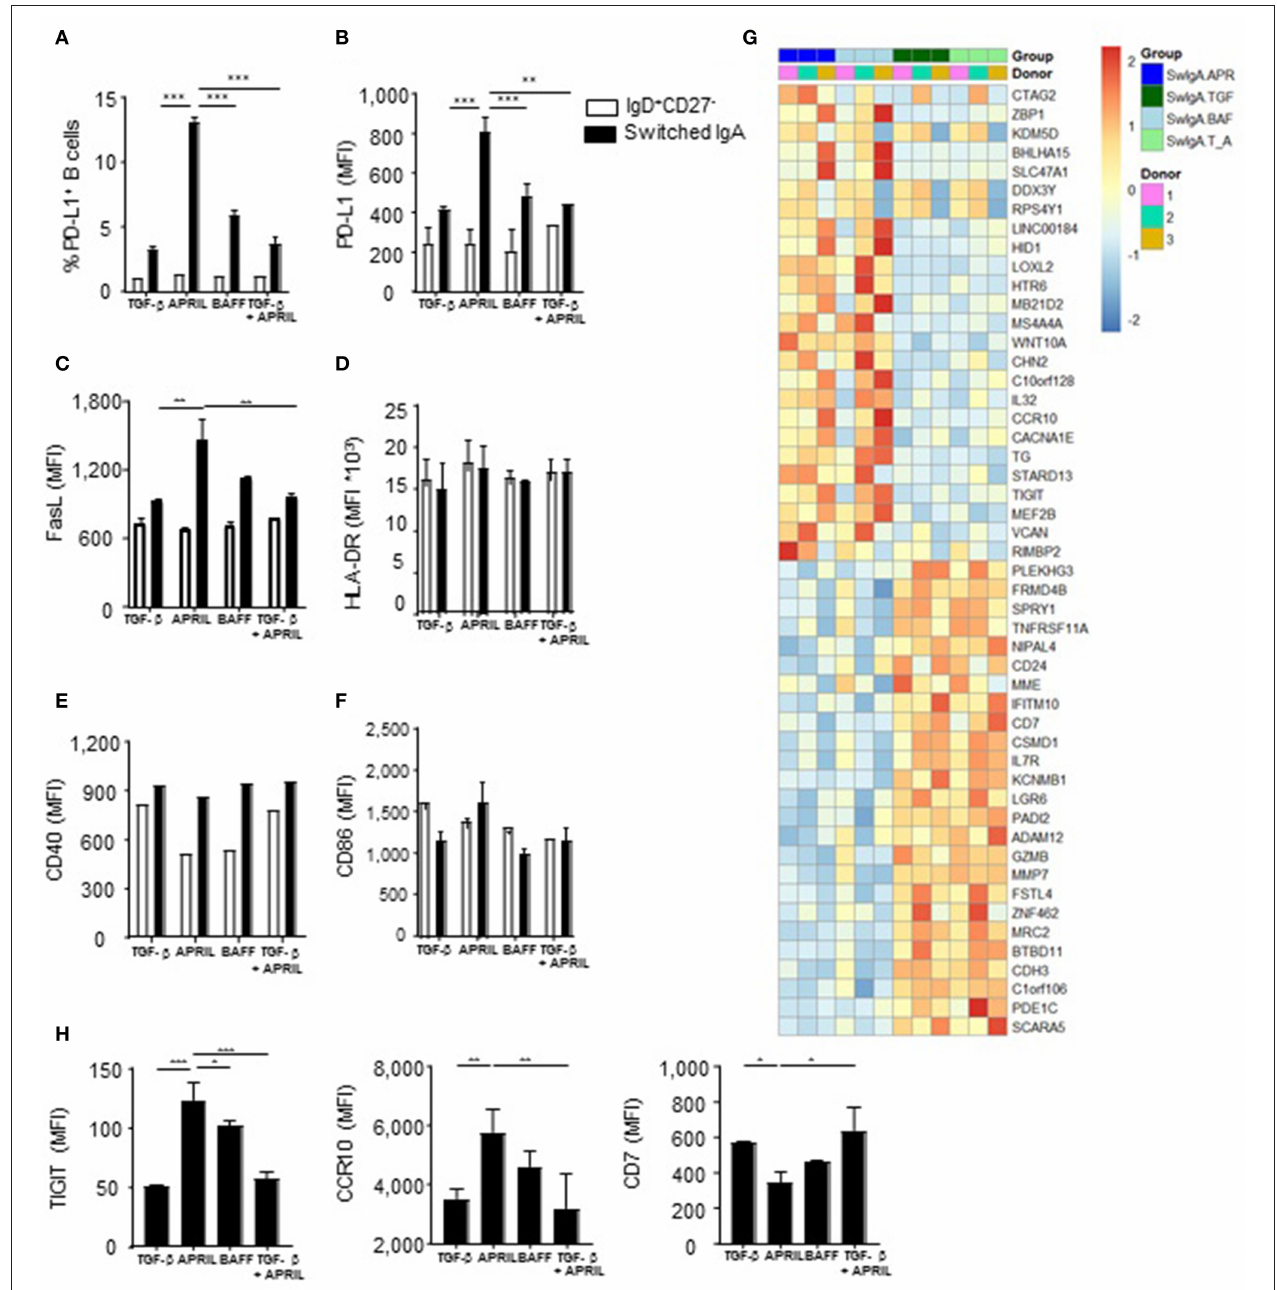
FIGURE 4 | APRIL-induced IgA + human B cells obtain a regulatory B cell phenotype by expressing high levels of IL-10, PD-L1, FasL and TIGIT. (A–H) A panel of co-stimulatory and inhibitory molecules as well as HLA-DR was assessed on IgD + CD27 − and class switched IgA + B cells after 6 days of culture on CD40L-expressing fibroblasts and IL-21 supplemented with TGF- β , APRIL, BAFF or a TGF- β + APRIL. (A) The frequency of PD-L1 + CD19 + B cells is shown. MFI of PD-L1 (B) , FasL (C) , HLA-DR (D) , CD40 (E) , CD86 (F) , and TIGIT, CCR10, and CD7 (H) was analyzed on naïve and class switched IgA + B cells. (G) Heatmap of relative expression of the top 25 most up- and downregulated genes in APRIL, TGF- β , BAFF or TGF- β + APRIL (SwIgA T_A) stimulated class switched IgA + B cells. Naïve B cells were cultured for 6 days on CD40L-expressing fibroblasts and IL-21 supplemented with TGF- β , APRIL, BAFF or a TGF- β + APRIL where after class switched IgA + were sorted and RNA was isolated. N = 3 donors per stimulation. (A–H) Mean ± SD are shown, n = 3. * P < 0.05, ** P < 0.01 and *** P < 0.001 (two-way ANOVA with Bonferroni multiple comparison test).